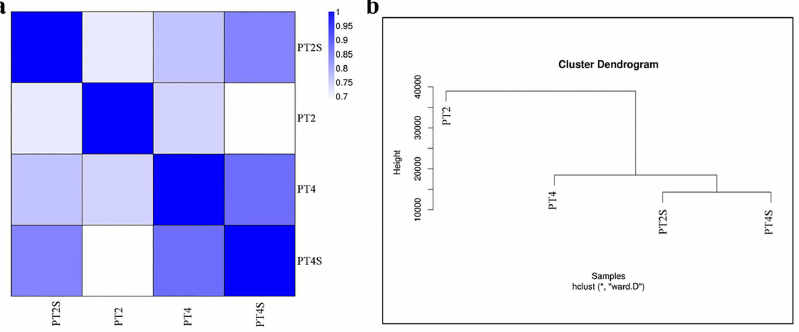
Fig 3. Heatmapof all correlation values (a) and cluster tree of the four accessions (PT2, PT2S, PT4, and PT4S)